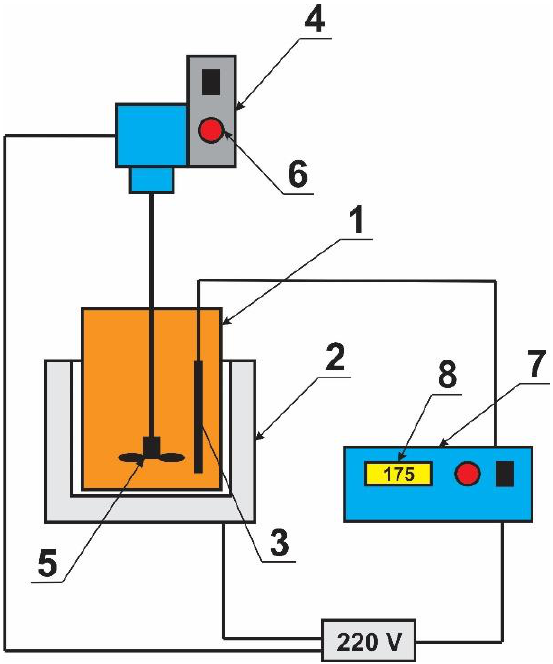
Figure 2. Scheme of the installation for the preparation of polymer bitumen binders.